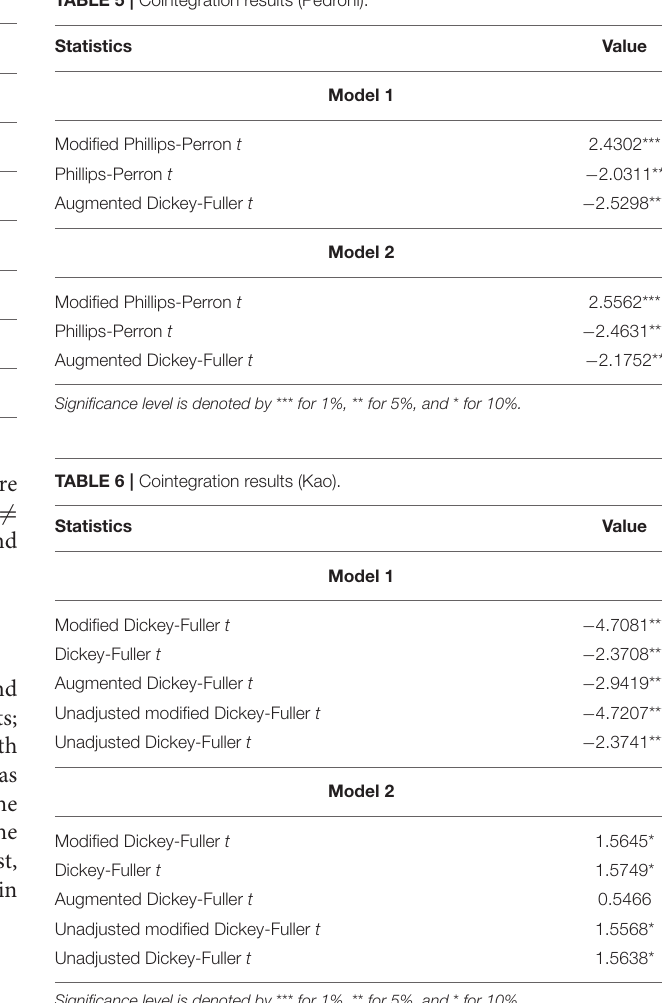
TABLE 5 | Cointegration results (Pedroni).